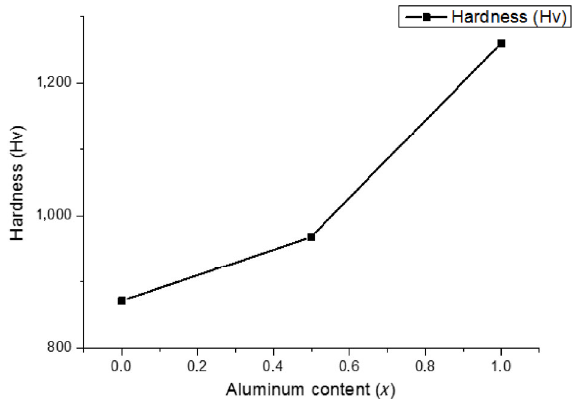
Fig. 6 Coefficient of friction of the CoCrFeNiTi 0.5 alloy as a function of sliding time at different